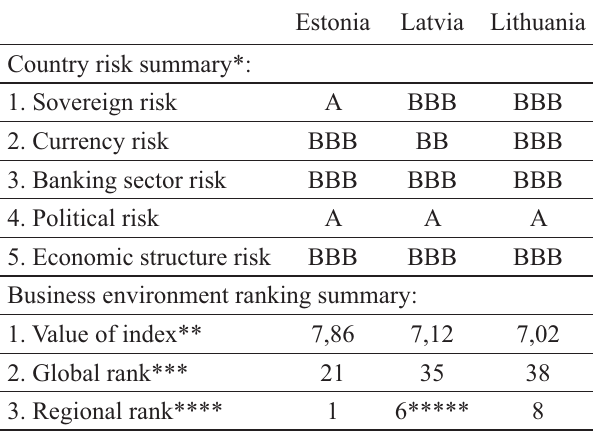
Table 1. Description of Country Risk and Business Environment of Estonia, Latvia and Lithuania (on the state of 15.07.2007) (Economist Intelligence Unit